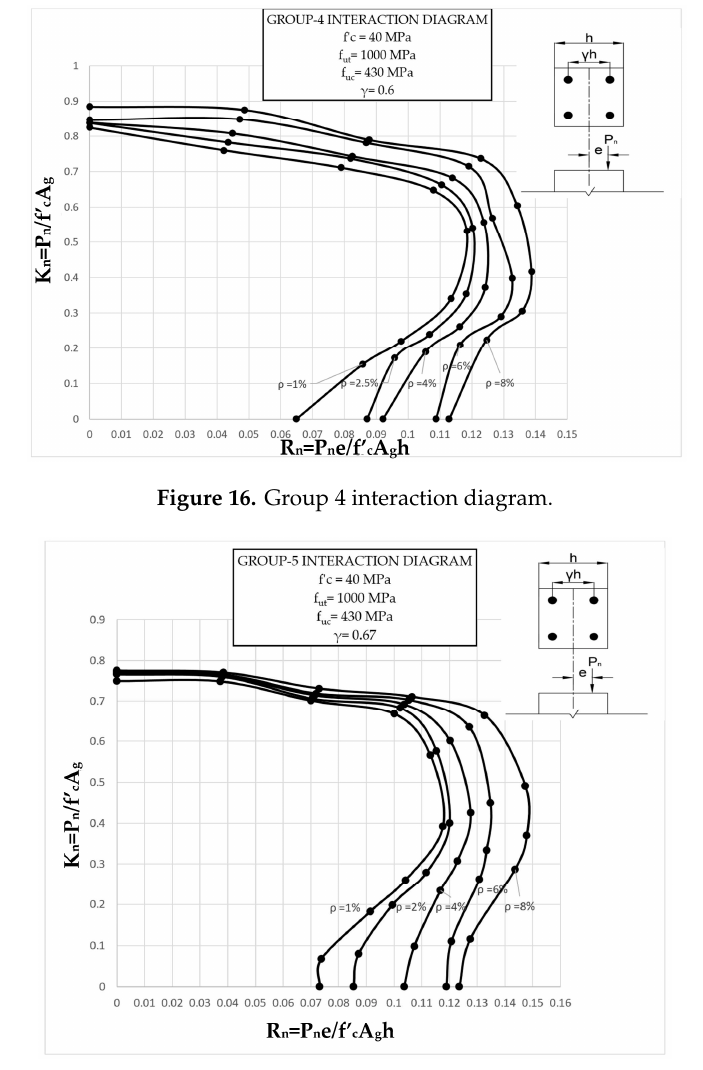
Figure 17. Group 5 interaction diagram.